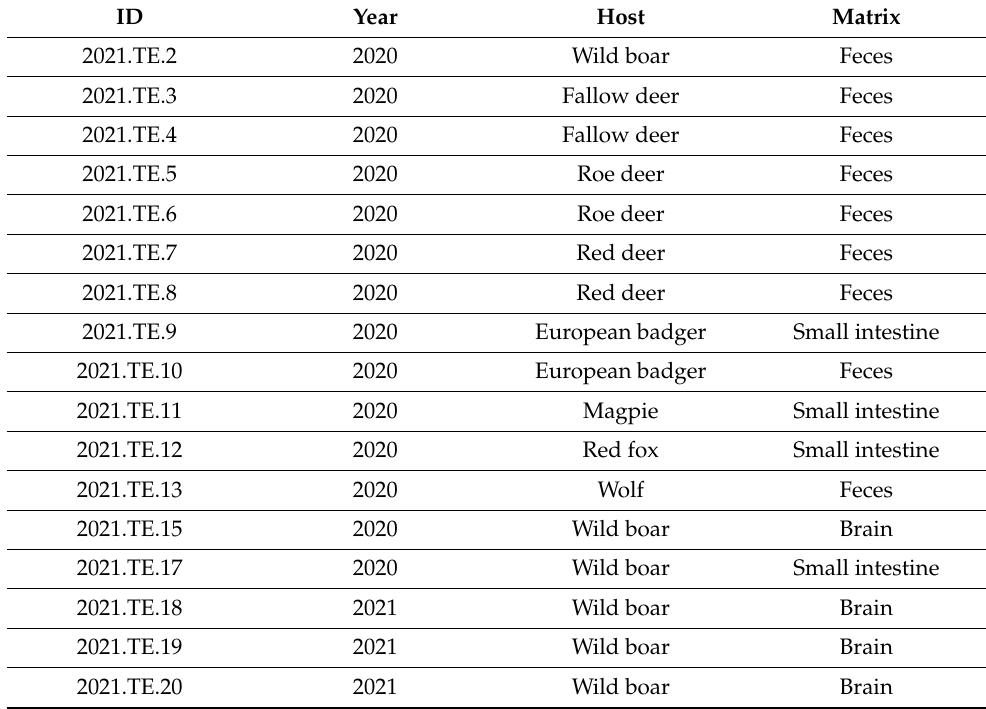
Table 1. Metadata of 17 strains used in this